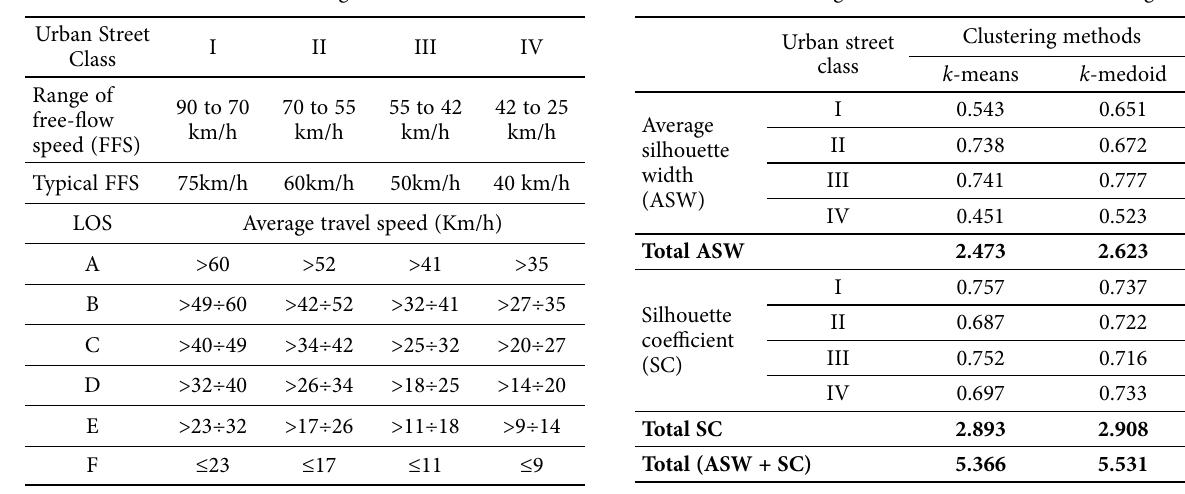
Table 3. Silhouette width and silhouette coefficient of